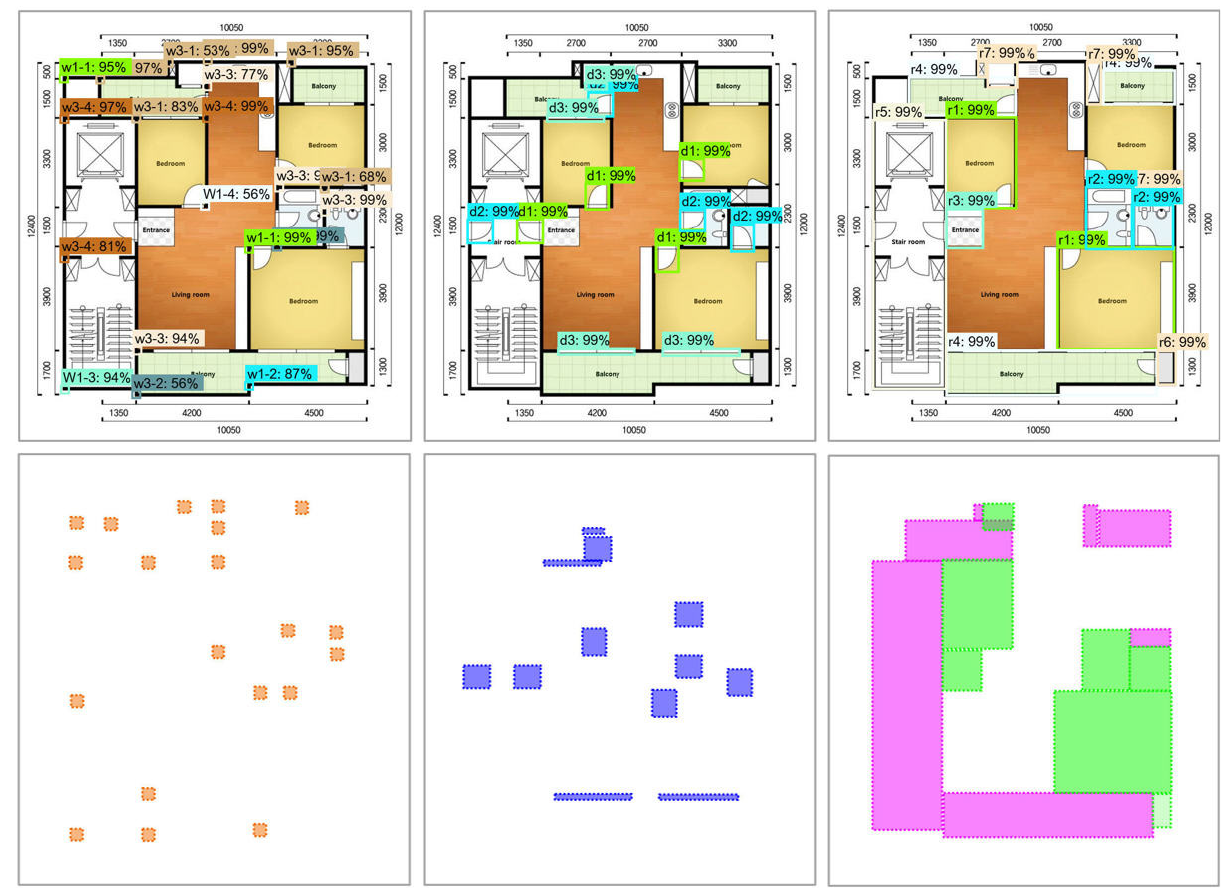
Figure 9. wall junction ( left )/opening ( center )/room ( right ) detection result (exclusive area: green, common area: pink).